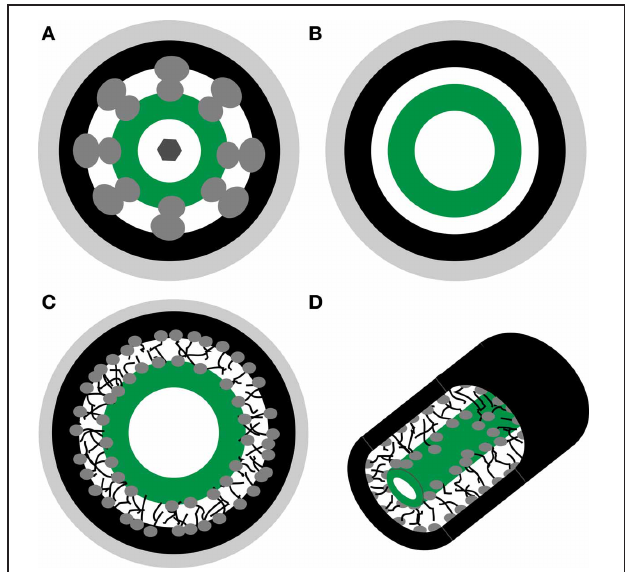
FIGURE 1 | Schematic representations of hypothetical plasmodesmata substructure. (A) Nano channel model proposed by Ding et al. (1992). (B) Cytoplasmic sleeve model proposed by Waigmann et al. (1997). (C,D) Cytoplasmic sleeve filled by polymer-meshwork hydrogel. Light gray—cell wall, black—plasma membrane, dark gray—proteins, green—desmotuble.